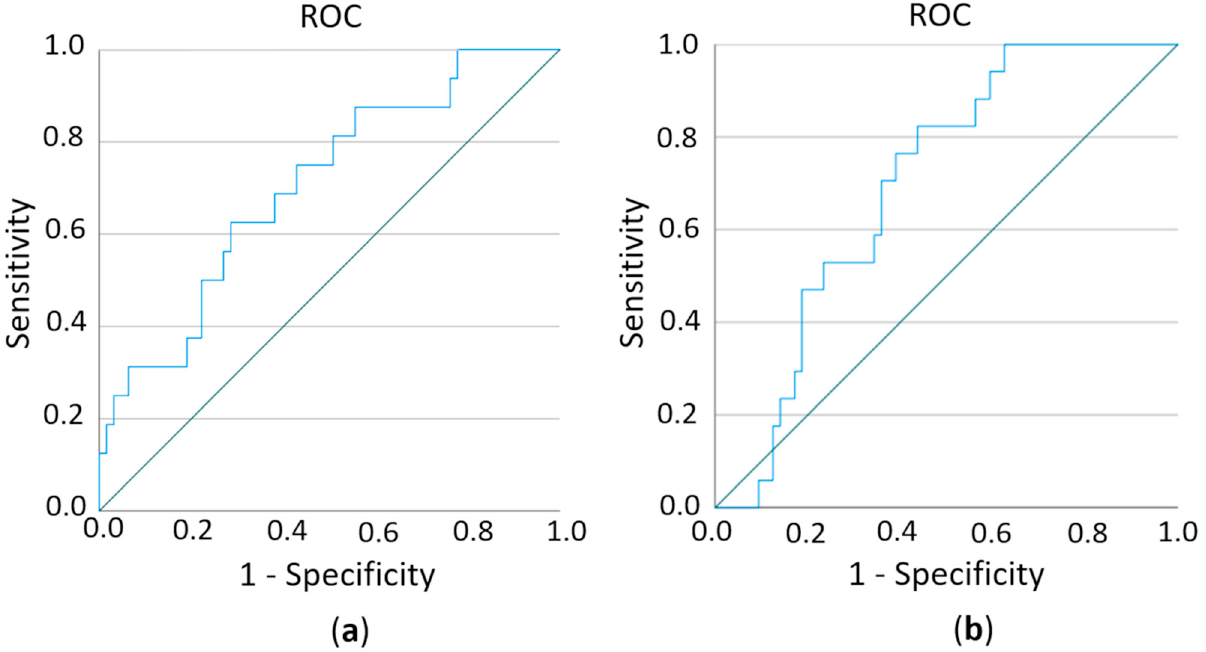
Figure 6. ROC (receiver-operating characteristic) curves of hsa-miR-576-3p ( a ) and hsa-miR-130a-3p ( b ) to test the predictive value of both miRs on brain metastases.